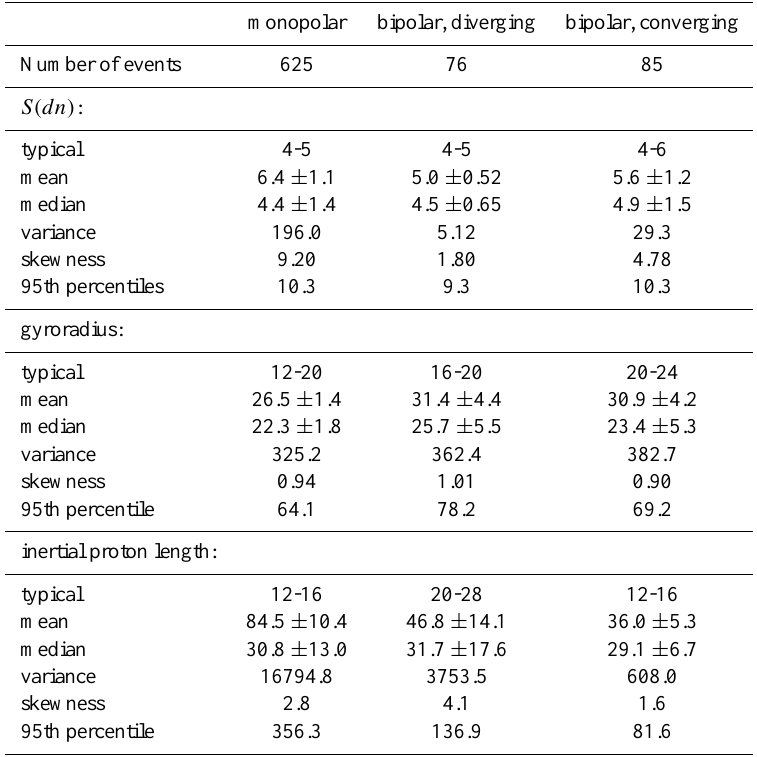
Table 2. Same kind of table as Table 1 but this time for the scale sizes of the density gradients, S(dn) , and the proton gyroradii and the inertial proton scale. For median and mean values, errors using the 95.5% confidence interval are given.